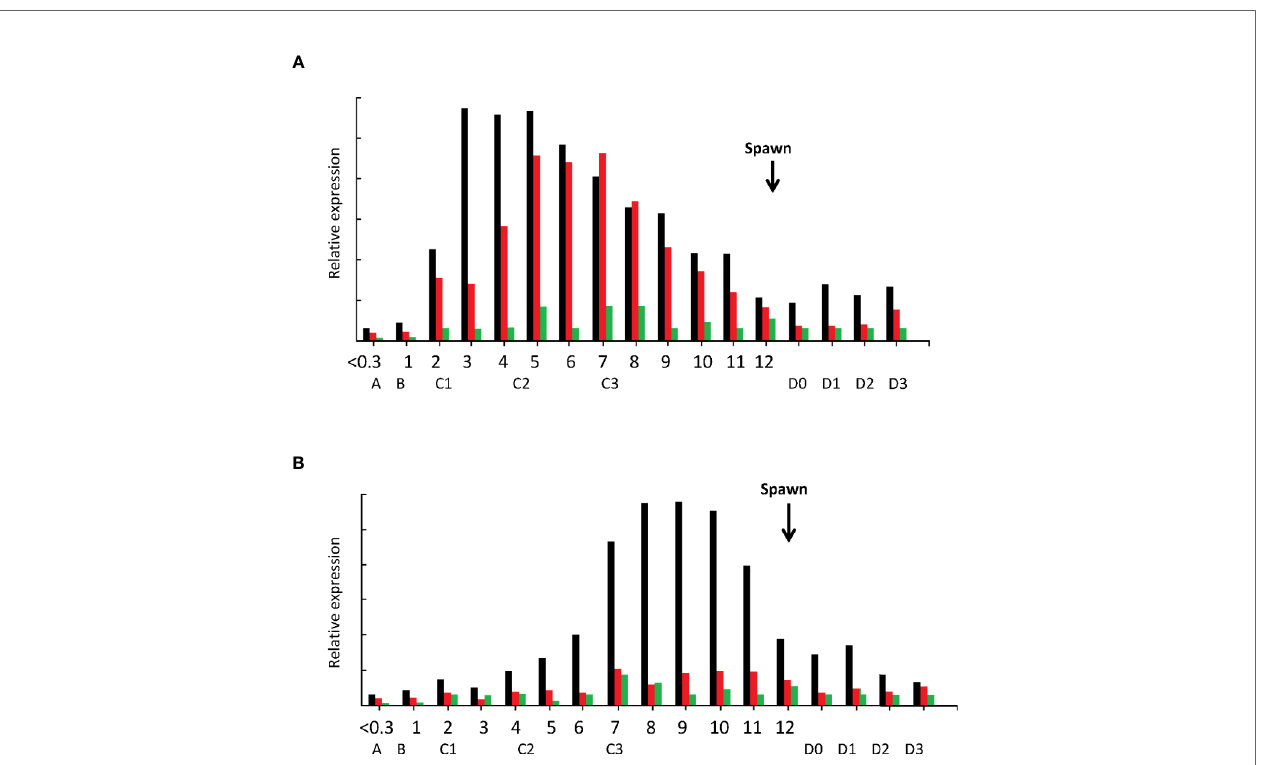
FIGURE 8 | Expression analysis of LvVg1 , LvVg2 , and LvVg3 in the hepatopancreas (A) and ovary (B) during female maturation cycle. The black bars are for LvVg1 , the red bars are for LvVg2 , and the green bars are for LvVg3 . The gonadosomatic index (GSI) was from 0 to 12%; the molt cycle stage was from A to D3. The arrow indicates the time of immediate post-spawn. Postmolt (A, B), early-Mid intermolt (C1 – 2), late intermolt (C3), early premolt (D0 – 1), middle premolt (D2), and late premolt